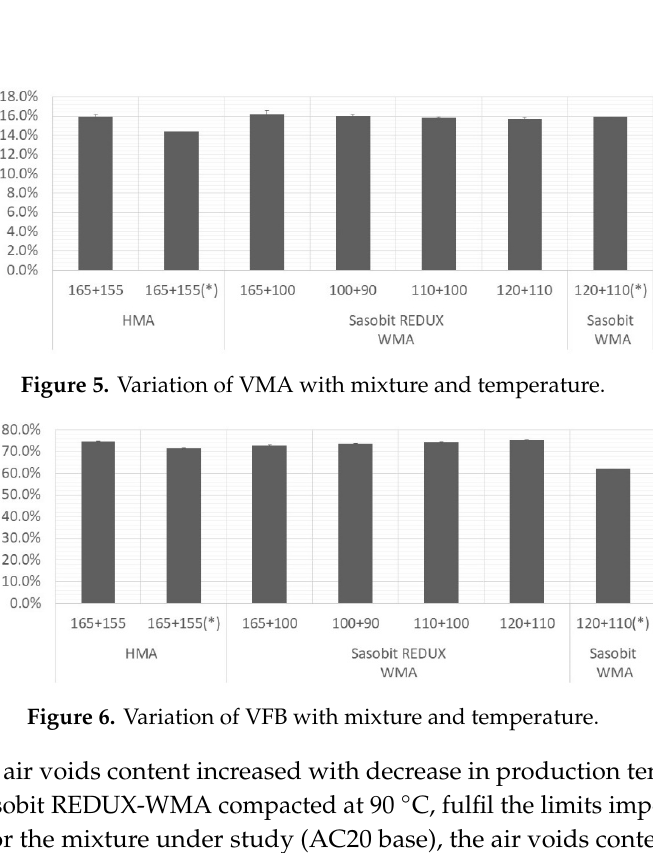
Figure 6. Variation of VFB with mixture and temperature.